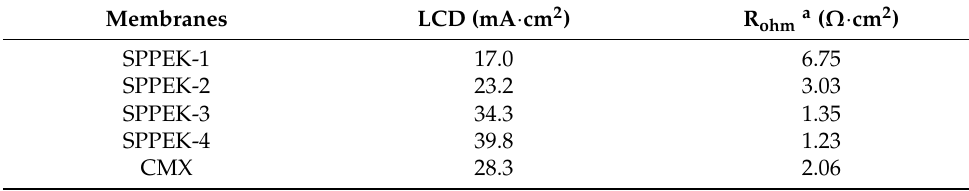
Table 4. Characteristic values from I – V curves.